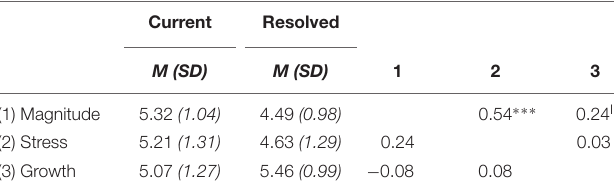
TABLE 1 | Means, standard deviations and correlations for the experience of identity conflict (current conflict – top diagonal, n = 68; resolved conflict – bottom diagonal, n = 21; Study